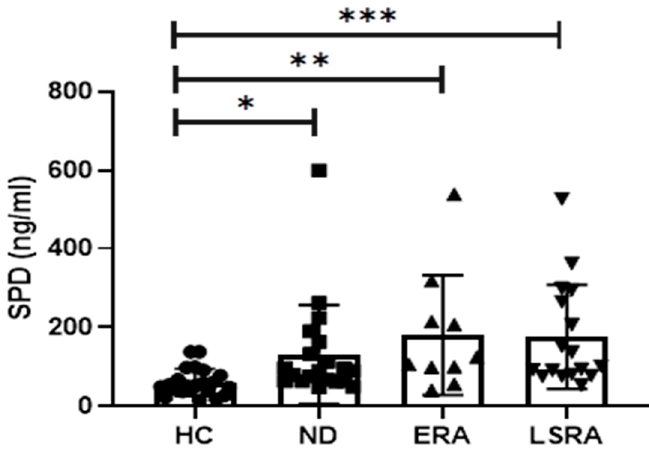
Figure 1. Comparison of SPD serum levels between ACPA-positive subjects and healthy controls. *: p < 0.05; **: p < 0.005; ***: p < 0.0005. Abbreviations: SPD, surfactant protein D; HC, healthy controls; ND,